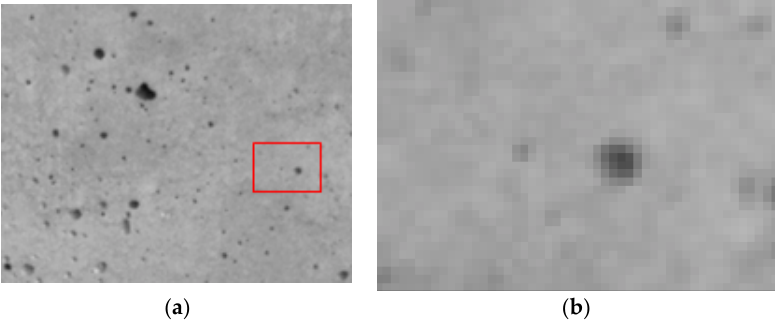
Figure 2. ( a ) Concrete surface pattern; ( b ) enlarged detail of a surface defect. Notice the degraded intensity surrounding the central dot and the low definition of the image at this